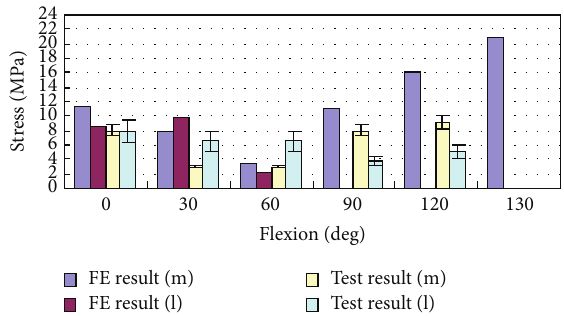
Figure 13: Comparison between experimentally measured stress applied to tibiofemoral joint and the FE results, where m refers to the medial femur and l refers to the lateral femur. The patella internal rotation (20 degrees maximum) was bigger than simulation results. There was little difference for patella relative medial tilting, excepting lateral tilting at 60 degrees flexion in one case. It was basically consistent in relative flexion of patellas, being linear with tibiofemoral flexion. The fluctuations of translation were larger than the rotation. The maximum medial translation in the experiment occurred within 30 degrees flexion earlier than the simulation of about 70 degrees flexion. However, the upward and backward translations were larger than the simulation. This difference may be caused by soft tissue relaxation in the cadaver